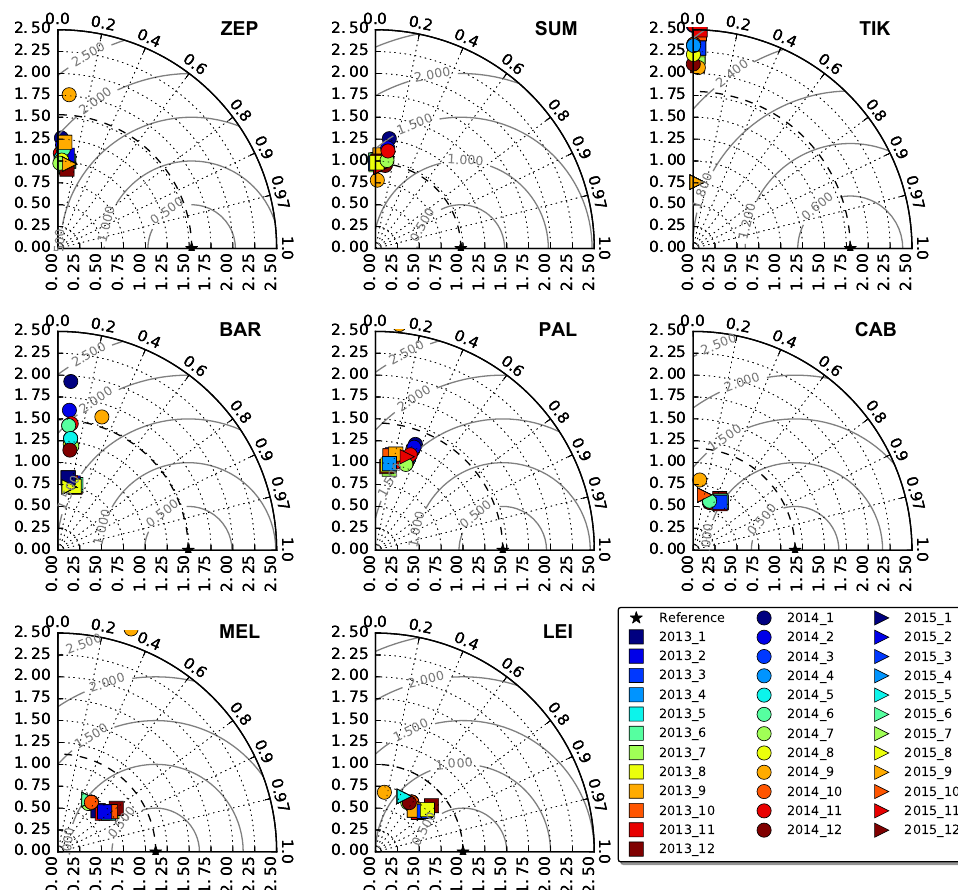
Figure 3. Taylor diagrams for the comparison of the prior (ECLIPSEv5) simulated concentrations with observations for all years (2013– 2015) for 12 BC species with different scavenging coefficients (Table 2). The radius indicates standard deviations normalised against the mean concentration (NSD); the azimuthal angle is the Pearson correlation coefficient, while the normalised (against observation) root mean square error (nRMSE) in the simulated concentrations is proportional to the distance from the point on the x axis identified as “reference” (grey